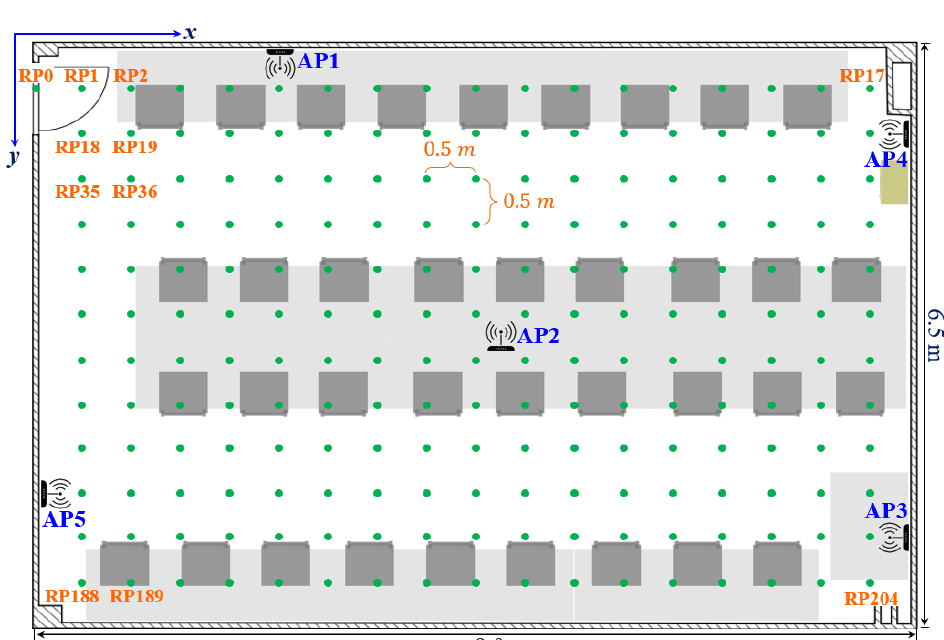
Figure 3. The positions of five APs and 205 APs in the office room. Table 4. The difference in environmental conditions in Case 1 and Case